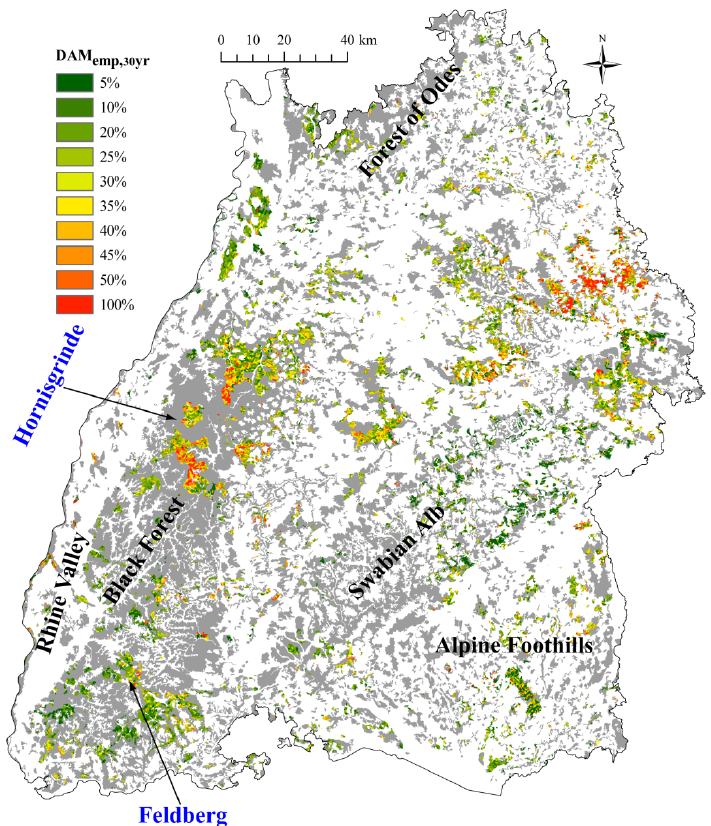
Figure 2. Map of proportions of storm-damaged timber in the period 1979-2008 ( DAM emp,30yr ). The legend values are highest class values. Grey areas indicate non-state forest areas for which no booking records are available. Blue arrow captions denote high mountain tops in the Black Forest.